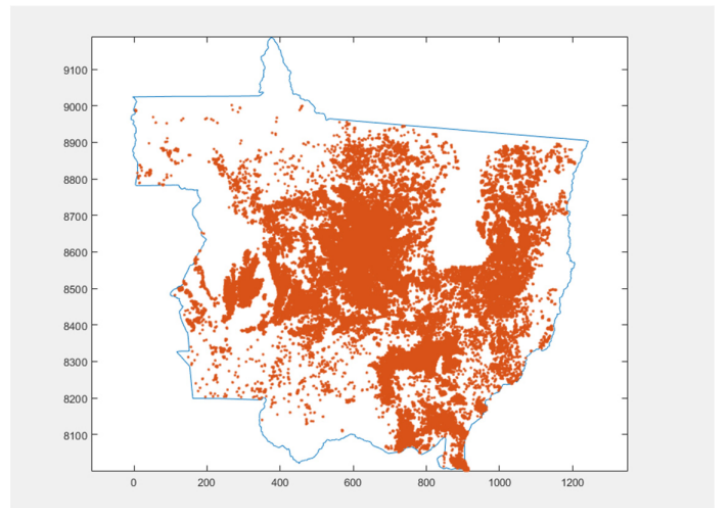
Figure 6. In it are marked all points that are near the highways up to 50 m and all points that are in or far up to 1 km from the properties. All other nodes in the mesh were considered distant.